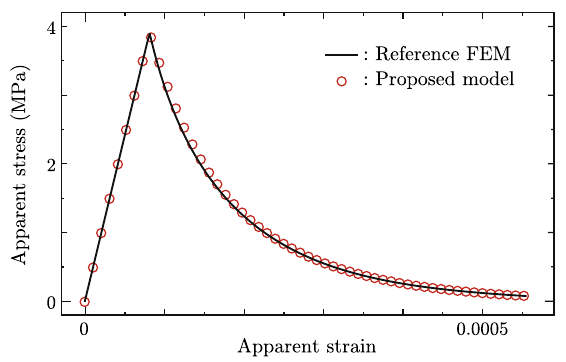
Fig. 6 Comparison of load–displacement curves in 1D bar problem